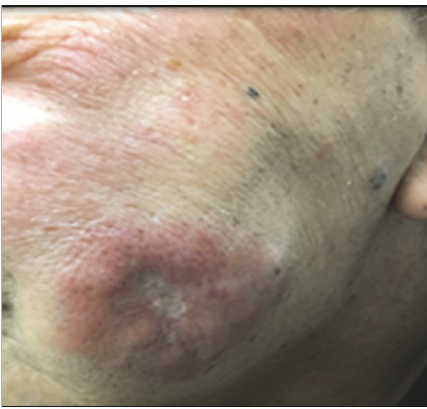
Figure 1: Heterogeneous pink plaque localized to the left